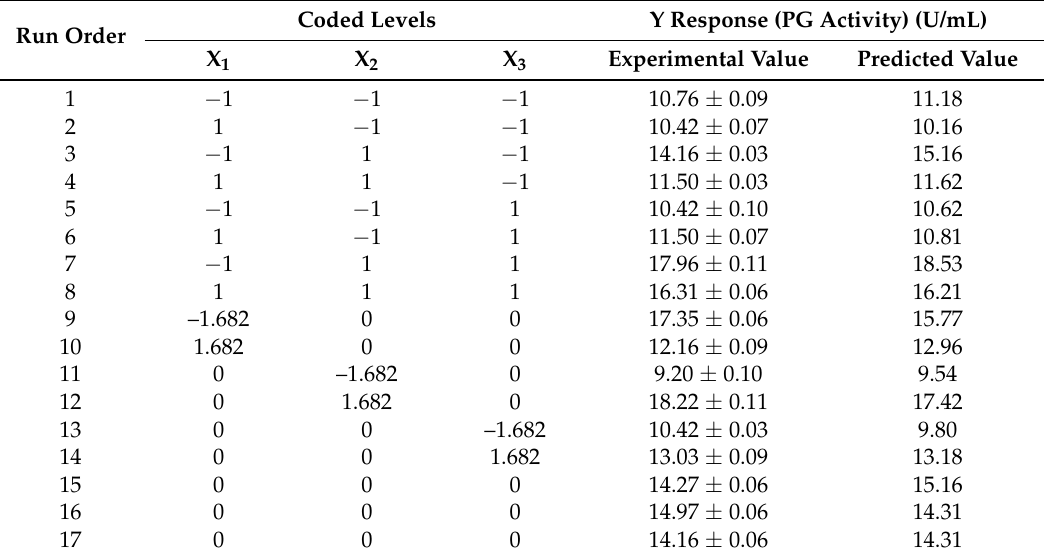
Table 5. Central composite design for the experimental and the corresponding responses to potentiation of PG activity.